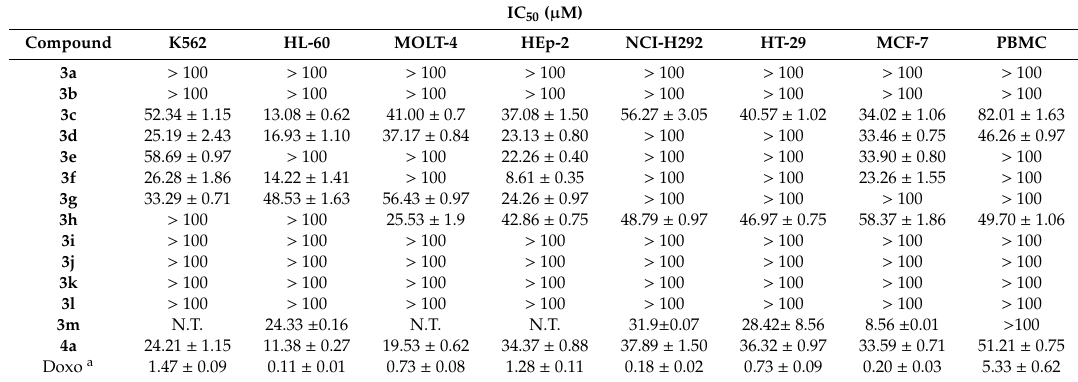
Table 1. IC 50 values ( µ M) of the arylsemicarbazone derivatives in tumor cell lines or Peripheral Blood Mononuclear Cells (PBMCs) performed by the MTT test after 72 h of incubation. IC 50 ( µ M)